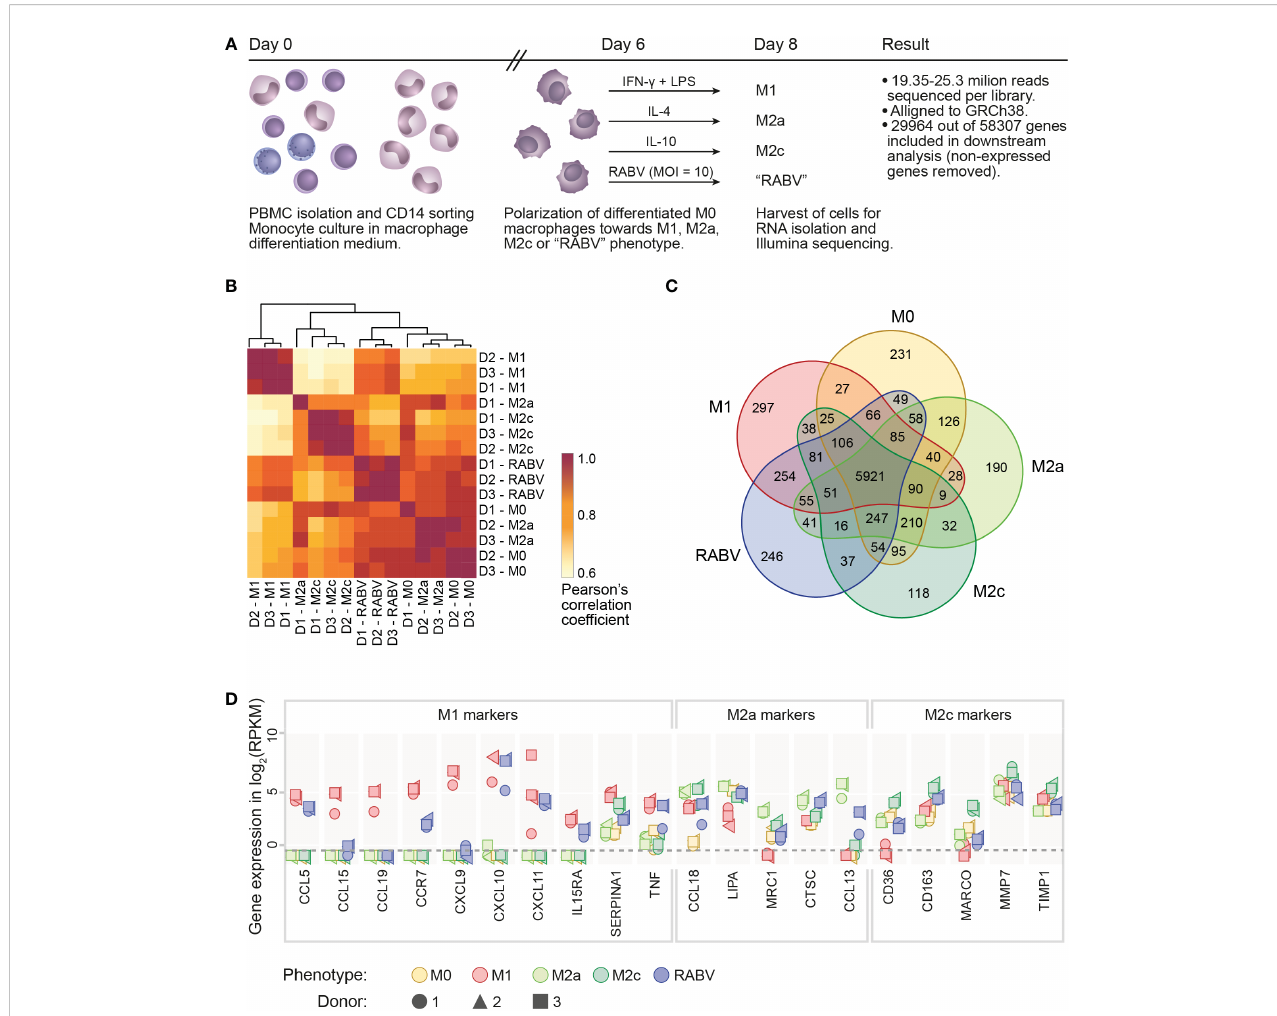
FIGURE 1 Experimental layout, initial analysis on sample variation and con fi rmation of the polarization model. A schematic overview of the presented transcriptome study is shown in (A) , indicating the experimental timeline, the experimental groups and the number of reads and genes retrieved from the Illumina sequencing. Clustering of the individual samples was based on calculated Pearson ’ s correlation coef fi cients (B) . The number of substantially expressed genes (mean RPKM > 0.5 of the three individual samples per phenotype), is presented in the Venn diagram in (C) . The expression of signature M1, M2a or M2c genes in all individual samples is shown, in log 2 RPKM, in (D) . The dotted line indicates the threshold for substantial expression, at 0.5 RPKM or -0.3 log 2 . For clarity, samples with an expression level of <0.5 RPKM are all placed below this